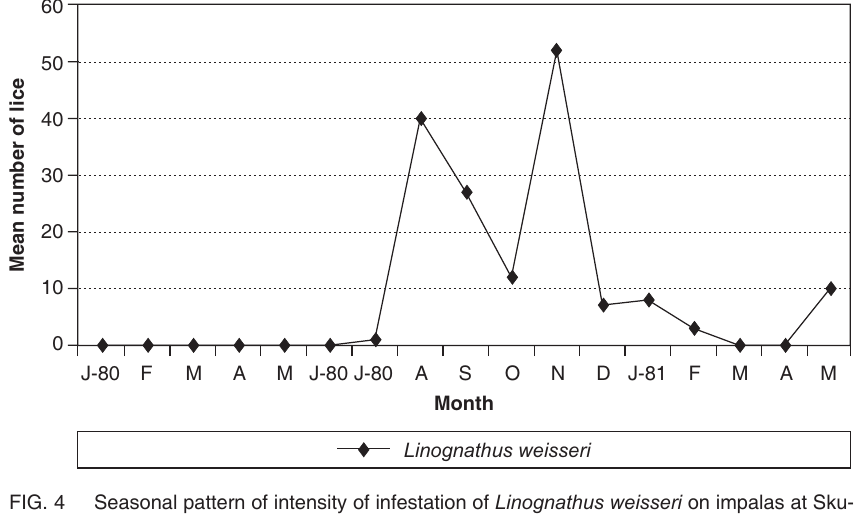
FIG. 4 Seasonal pattern of intensity of infestation of Linognathus weisseri on impalas at Sku- kuza and in the Mbiyamiti regions, Kruger National Park, South Africa during 1980/81. The monthly sample ranged from 4–13